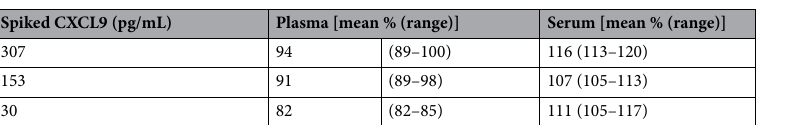
Table 2. Spike-recovery test. Spike-recovery assays were used to determine the accuracy of the HISCL CXCL9 assay. Data show the amounts of CXCL9 measured as percent recovery of the original spiked concentration in ten individual serum or plasma